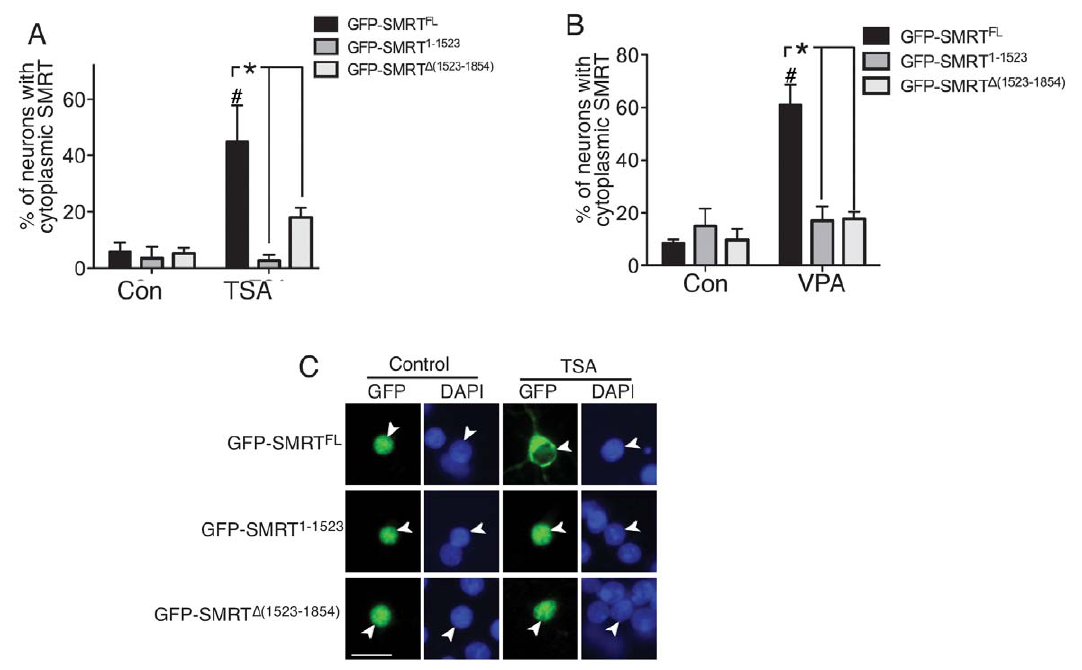
Figure 3. The RD4 region is necessary to mediate SMRT export following HDAC inhibition. Analysis of the cellular localization of the indicated GFP-SMRT fusions, transfected into neurons and treated with TSA (A) or VPA (B). * p , 0.05 (n=3). # p , 0.05 comparing control and drug- treated conditions for each SMRT construct. C) Example pictures from (A). Scale bar 20 m m.